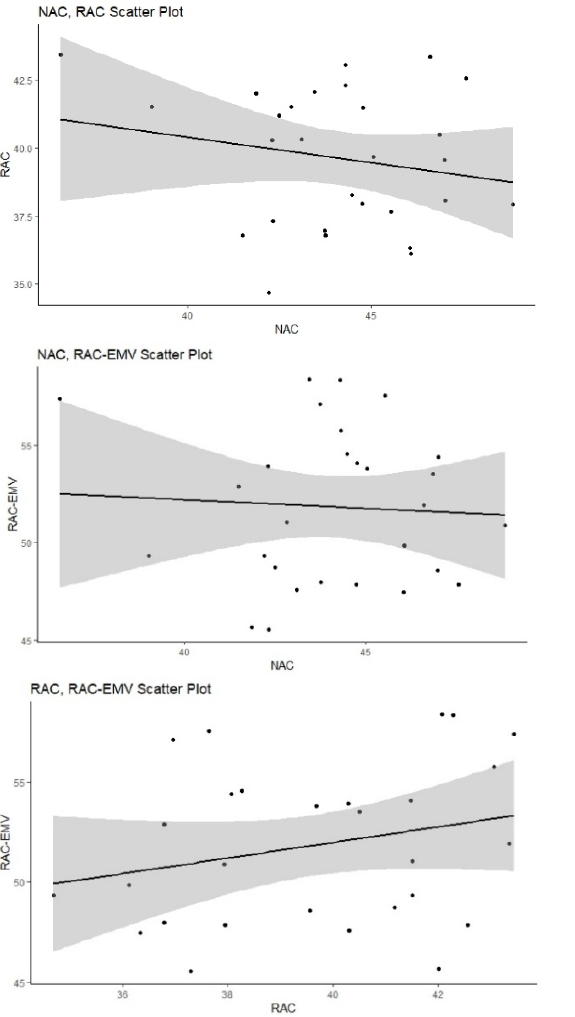
Figure 3. Scatter plots between concrete types with confidence intervals. Variance analysis (ANOVA) measures the significance of compressive strengths on concrete types and the results of ANOVA is given in Table 9. Statistically, the relationship between the groups were significant at %5 significance level ( p -value = 0.00 < 0.05). It is known that TS-500 [42] considered %10 significance level with higher tolerance compared to 5% significance level [43]. Also, a multiple comparison test was used to determine which concrete types were significant (Table 10) and here, if the confidence intervals for the multiple comparison test contained a value of “0”, the bilateral relationship was not meaningful. Accordingly, when Table 10 was examined, it was found that the relation- ships of (NAC)-(RAC), (NAC)-(RAC-EMV), (RAC-SF)-(RAC), (RAC-EMV)-(RAC) and (RAC-EMV)-(RAC-SF) were significant at 5% significance level. However, the relationship between (NAC)-(RAC-SF) was not significant. Table 9. ANOVA results with means and interval plots for concretes. Interactions Sum of Squares df Mean Square F Sig. Between Groups 2267.729 3 755.910 91.849 0.000